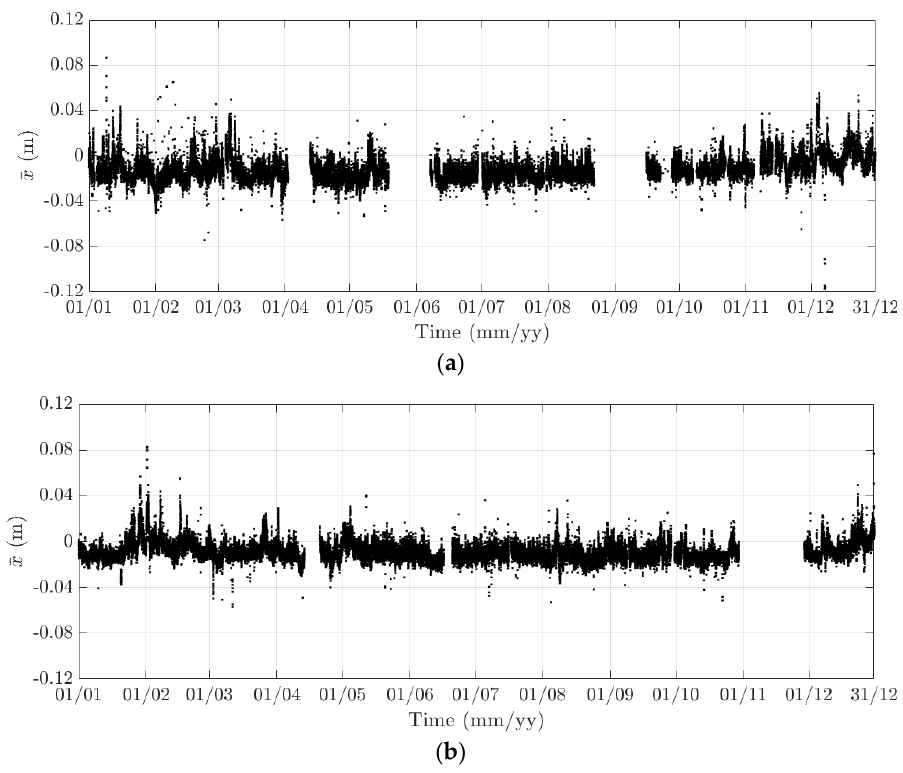
Figure 10. Variation of the 10-min mean of the longitudinal response at the mid span of the FRB in ( a ) 2015 and ( b ) 2016.